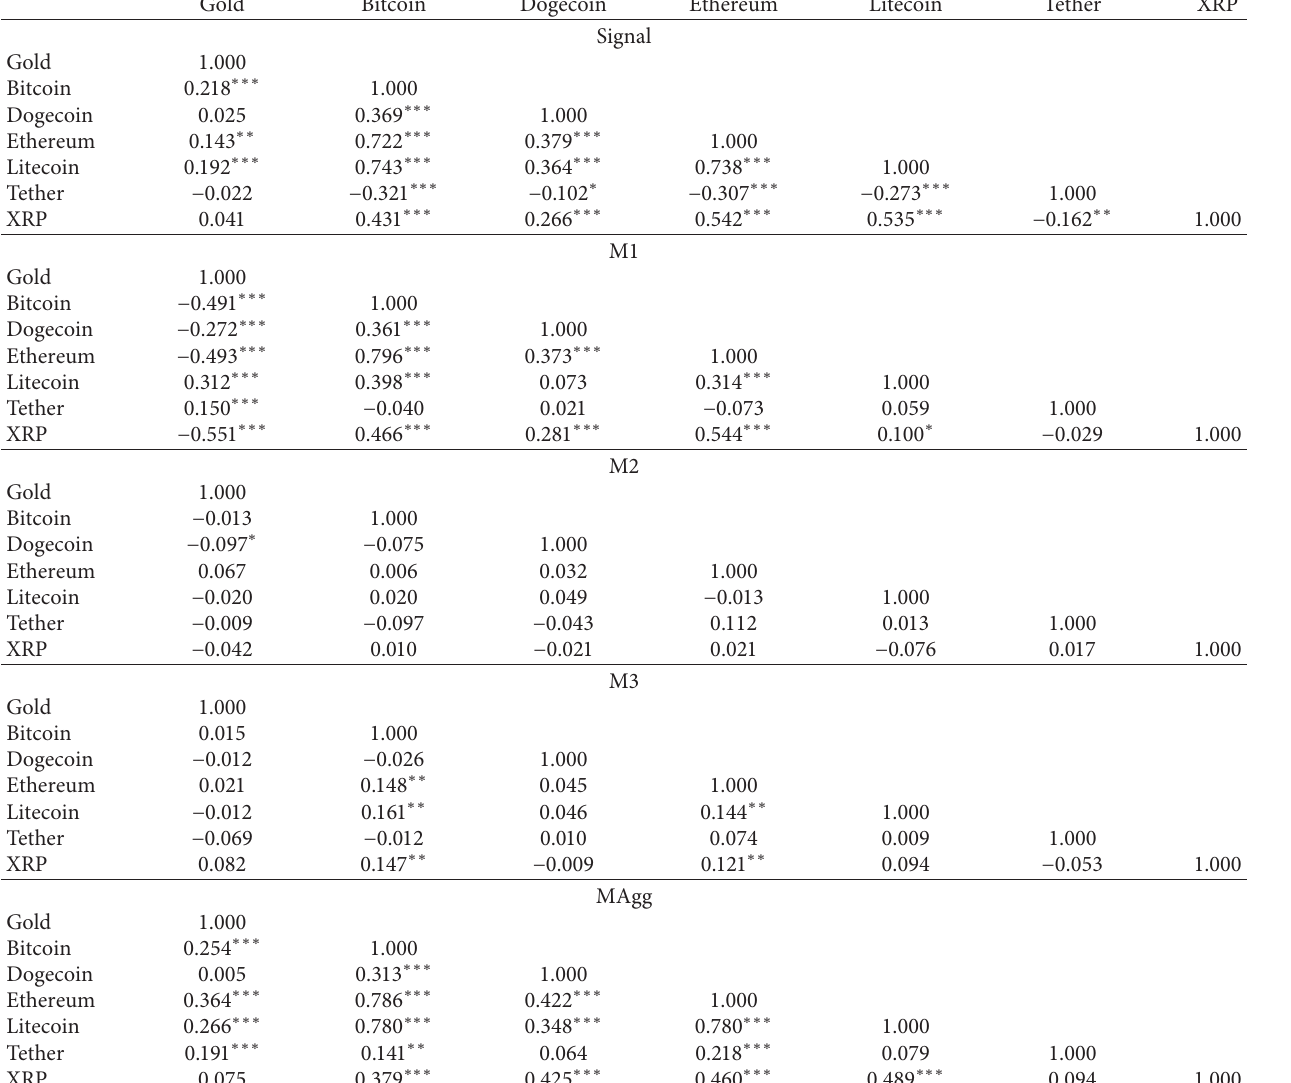
Table 2: Correlation